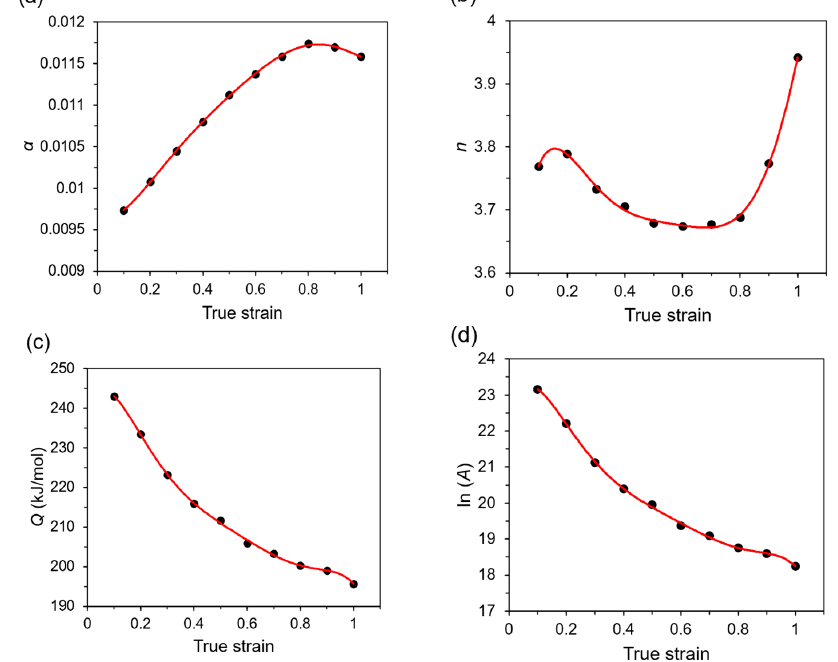
Figure 5. Material parameters ( a ) α , ( b ) n , ( c ) Q , and ( d ) ln A for various true strain levels. Table 1. The coefficients of material parameters α , n , Q , and A obtained basing on polynomial fitting.